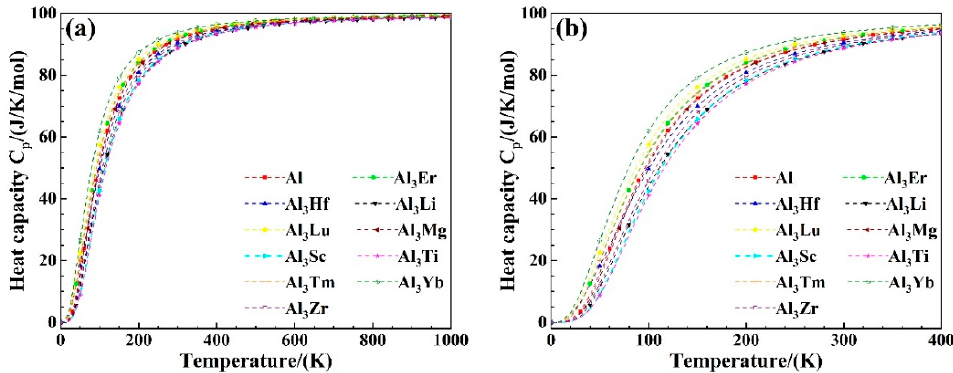
Figure 2. ( a ) The isobaric heat capacity C p –temperature curves of pure Al and L1 2 -Al 3 M structures; ( b ) C p in a narrower temperature range of 0–400 K. ( b ) C p in a narrower temperature range of 0–400